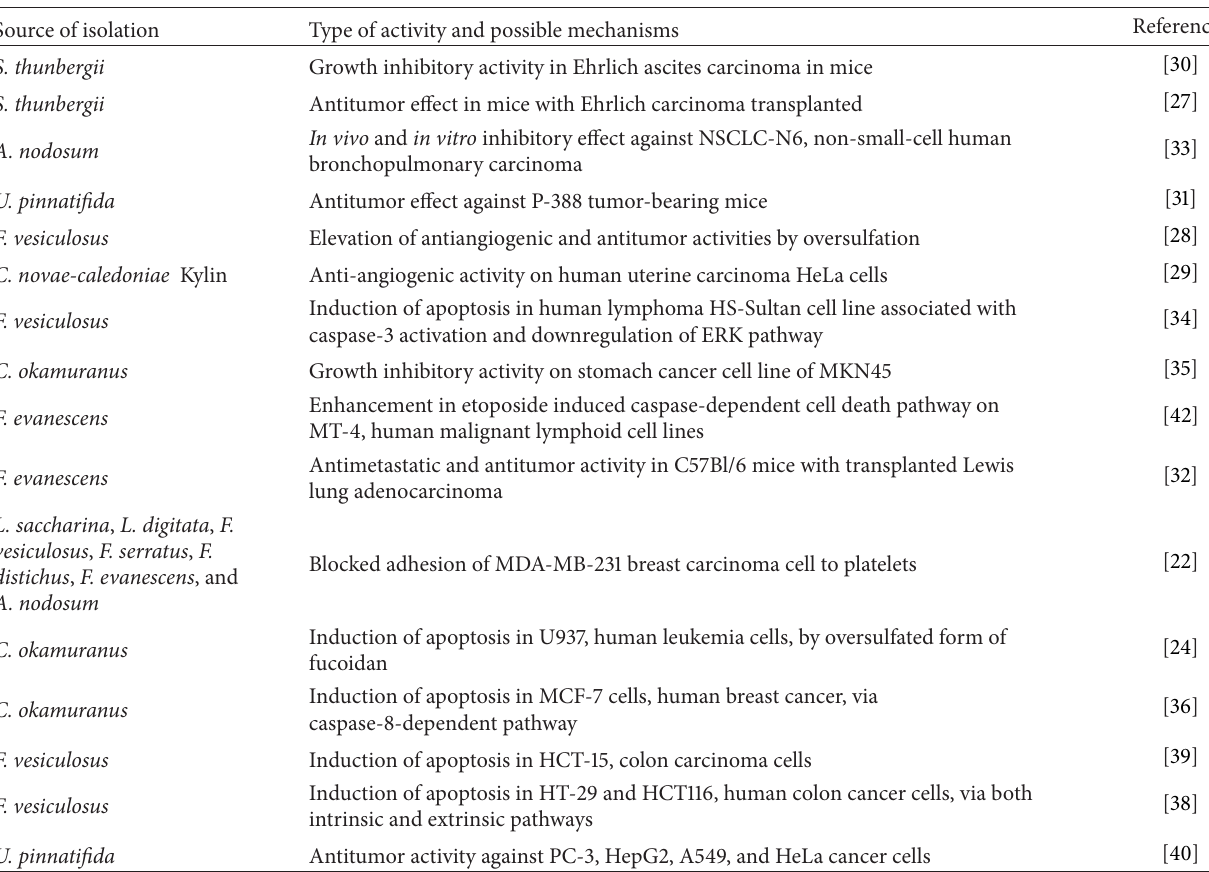
Table 1: Anticancer and antitumor activity of fucoidans isolated from brown